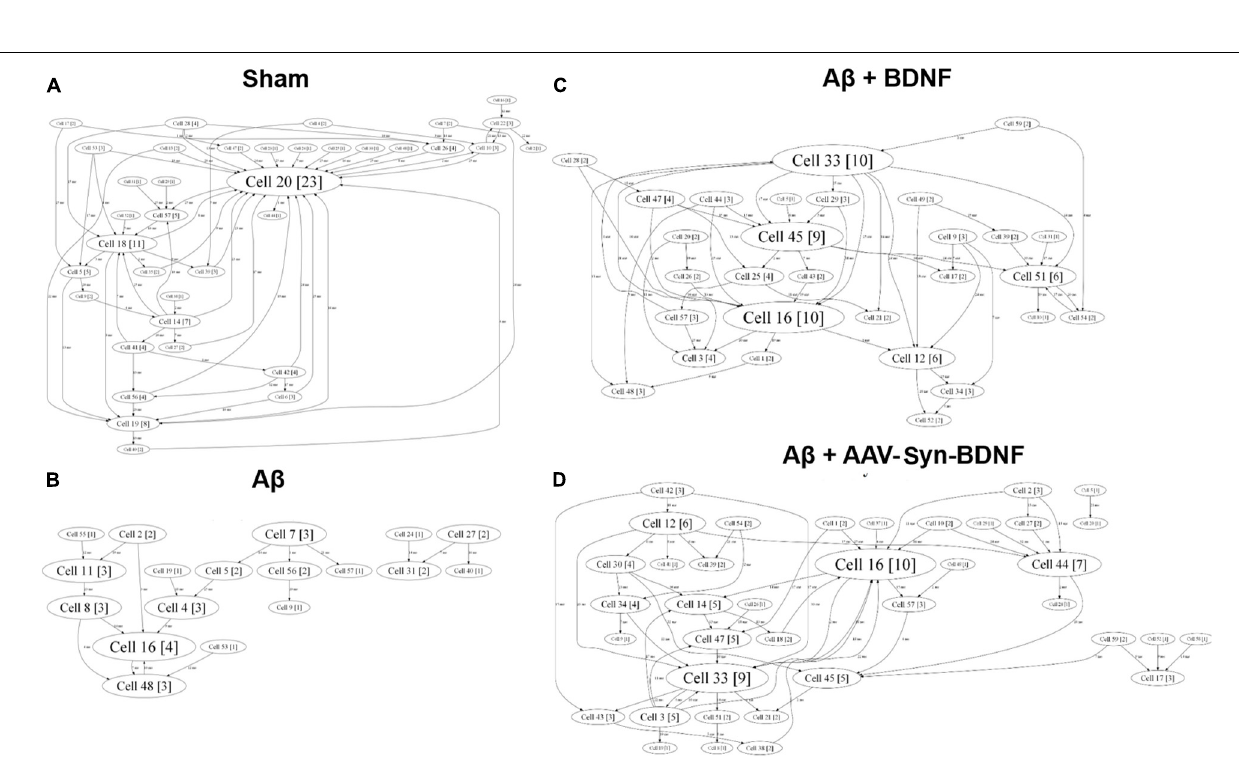
Frontiers in Cell and Developmental Biology |